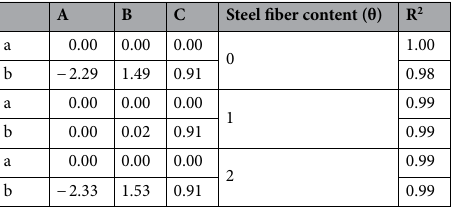
Table 8. Results of θ-value parameter analysis (Flexural strength